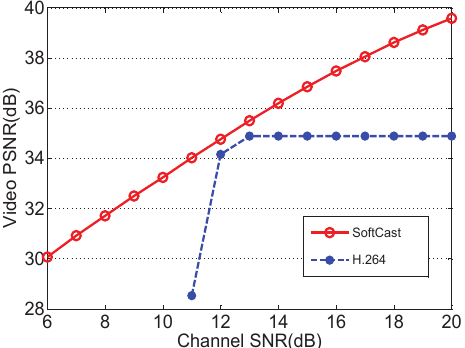
Figure 9: Performance comparison of scalable qual- ity between SoftCast and